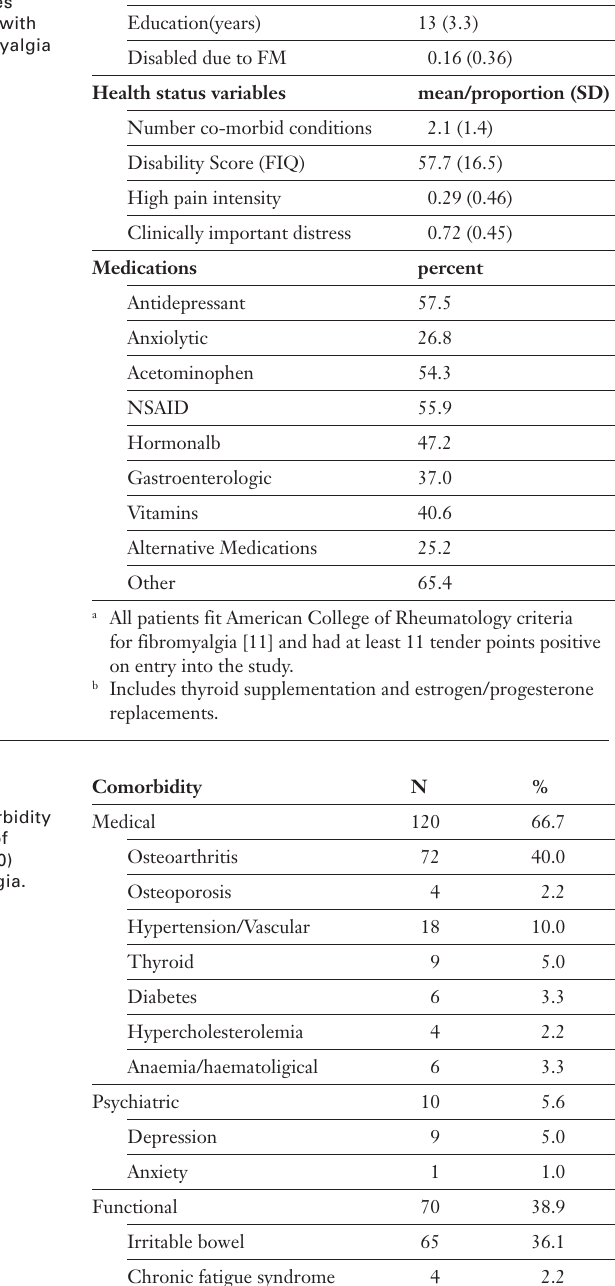
in the subjects with primary fibromyalgia (n = 180). a